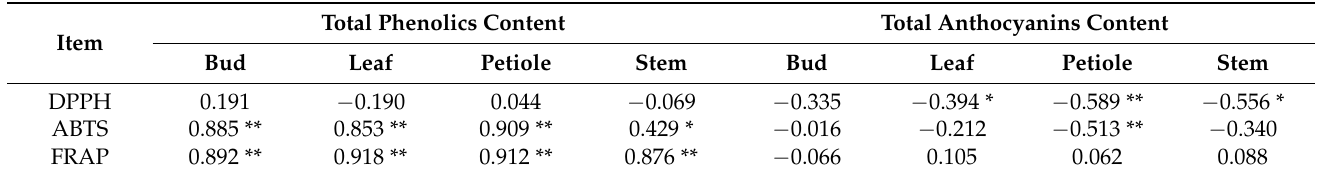
Table 5. Correlation of antioxidant activity and total phenolics and total anthocyanins contents in buds, leaves, petioles, and stems from 11 leafy sweet potato